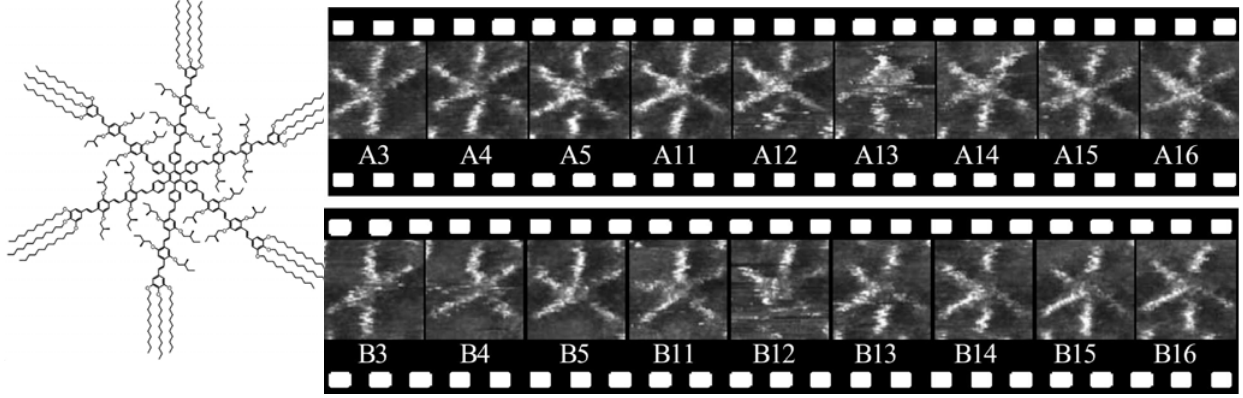
Figure 10. Dynamic processes of a hexapod molecule at the solution–HOPG